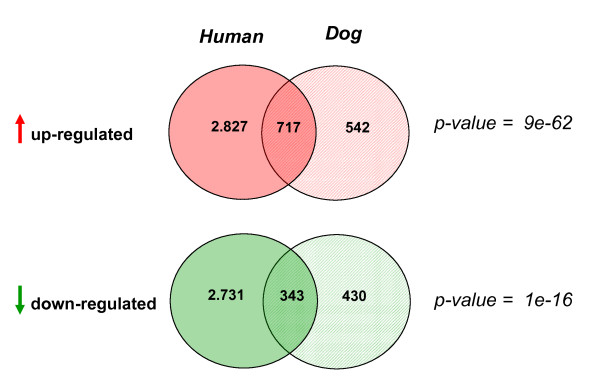
Up and Down regulated genes in Human and Dog. Venn diagrams representing up- and down-regulated genes in human and dog mammary tumors. On the right side, the Fisher's exact test p-values of the overlaps are reported.